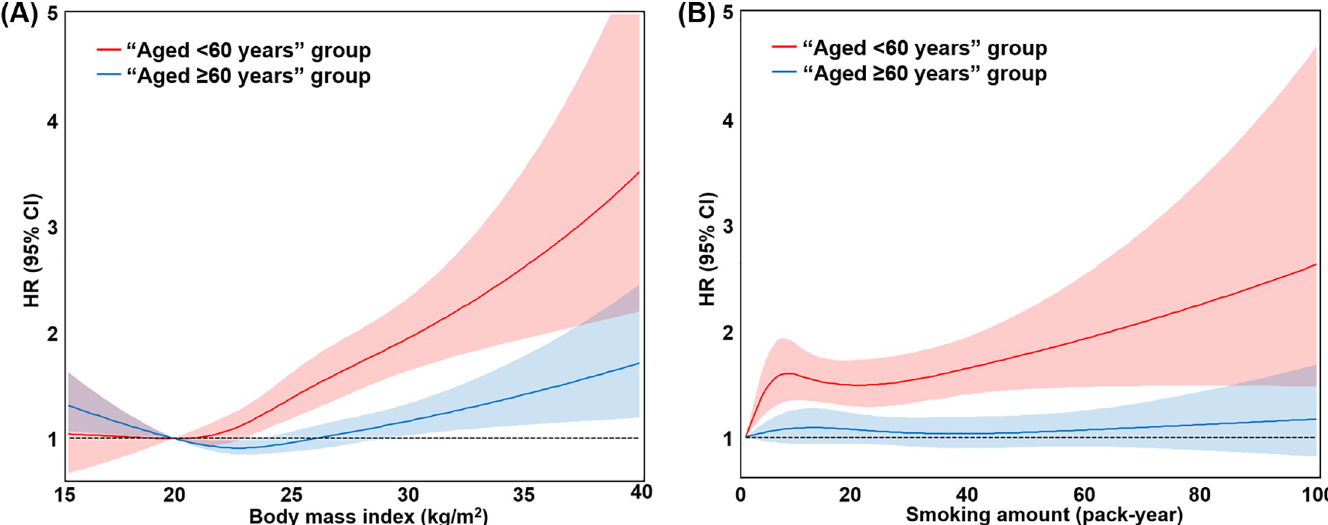
Fig 2. (A) Body mass index and adjusted hazard ratios for new-onset AF in the “aged < 60 years” and “aged � 60 years” groups. (B) Smoking frequency (pack-year) and adjusted hazard ratios for new-onset AF in the “aged < 60 years” and “aged � 60 years” group. Hazard ratio (HR) for each risk factor was adjusted for by the Cox regression analysis using these variables: age, sex, previous ischemic stroke or transient ischemic attack, previous myocardial infarction, heart failure, hypertension, diabetes mellitus, chronic obstructive pulmonary disease, chronic kidney disease, obesity, smoking, excessive alcohol intake, and low physical activity (obesity was excluded in the model for [A], smoking status was excluded in the model for [B]). A reference for hazard ratio was a BMI of 20 kg/m 2 in (A) and never-smokers in (B). Color areas are 95% confidence intervals for the spline curves. HR, hazard